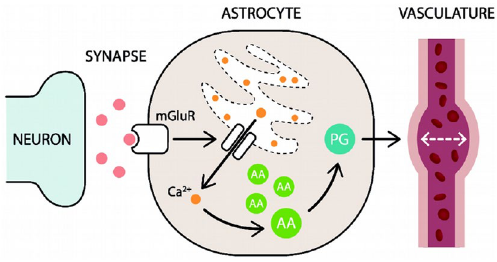
Figure 1. Diagram of the model of neurovascular coupling. We consider a feedforward system that starts at the neuronal level. Glutamate spilled from the synaptic clefts toward the perisynaptic space activates, through metabotropic glutamate receptors (mGluRs), the calcium (Ca 2 + ) signaling cascade in astrocytes. The increase in cytosolic Ca 2 + levels in astrocytes induces the production and release of vasomodulators (prostaglandin, PG) derived from free arachidonic acid, leading to the variations of the arteriole